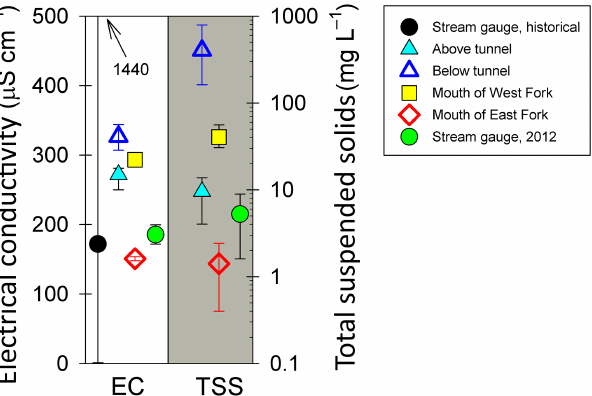
Figure 3. Stream-water electrical conductivity and total suspended solids (note log-scale axis) from historic data collected at stream gauge, above and below the thermokarst tunnel, observed at the mouths of the West and East Forks of Crescent Stream (just above their confluence), and at the stream gauge site in January 2012. See Fig. 3c for sampling location map. There are no historic TSS data available from Crescent Stream